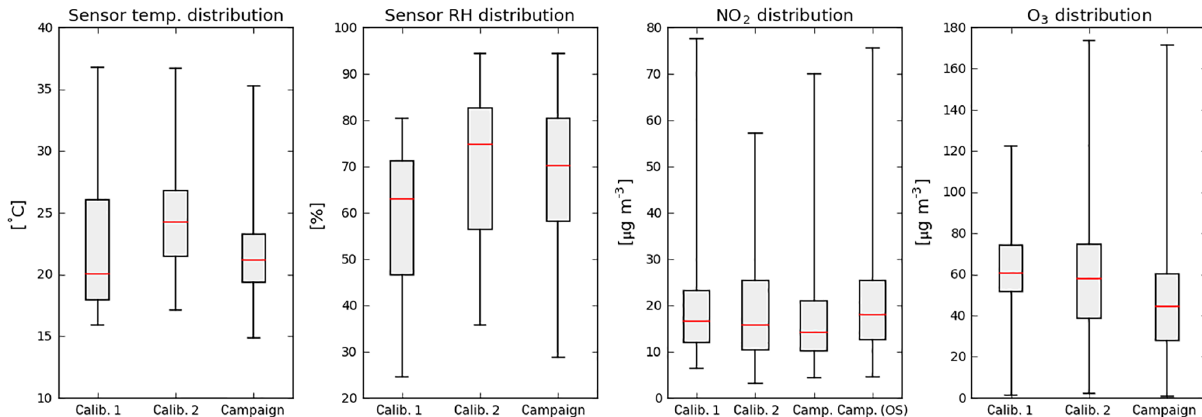
Figure 4. Box-and-whisker diagrams of hourly ambient parameters during the two calibration periods and the measurement campaign. The box edges indicate the 25th–75th percentile; the whiskers the minimum and maximum values. The median is indicated in red. Temperature and RH are based on the average values of all sensors devices, NO 2 and ozone are taken from the reference station at Vondelpark. For comparison, NO 2 from the reference station at Oude Schans (OS) is also